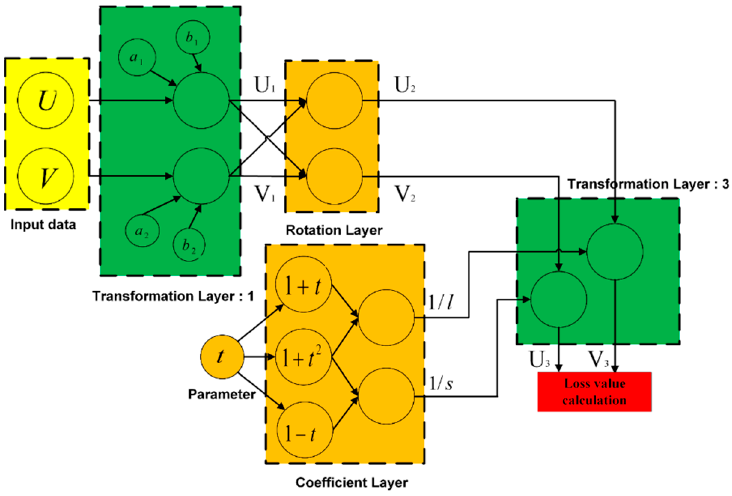
Figure 4. Structure of the signal flow network.